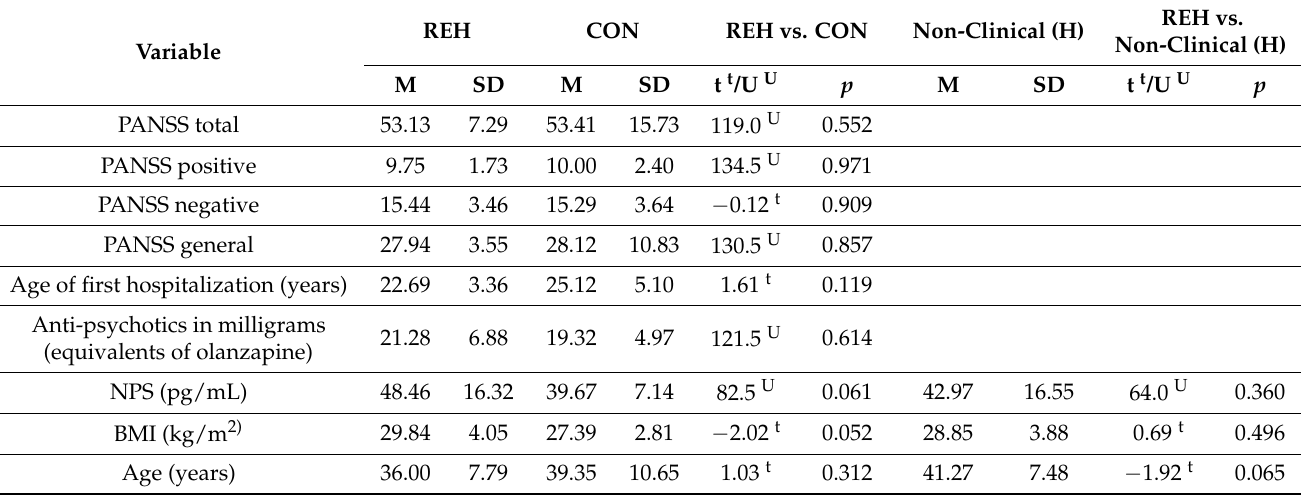
Table 1. Initial (T1) parameters and results for REH, CON, and non-clinical